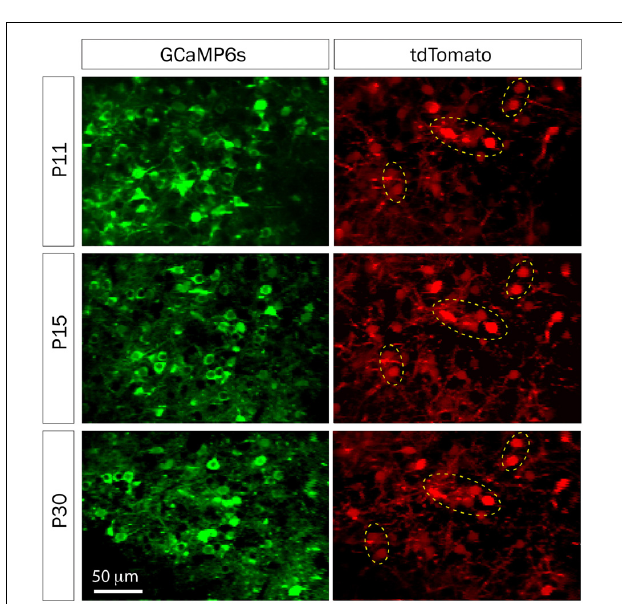
FIGURE 5 | td-Tomato expression to help identify the same GCaMP6s field of view for calcium imaging. Representative fields of view of GCaMP6s and td-Tomato-expressing neurons in barrel cortex of a mouse at three different postnatal ages. This animal was electroporated in utero at E16 with a plasmid encoding the red fluorescent protein td-Tomato and then was injected with rAAV-GCaMP6s at P1. Expression of td-Tomato allowed us to identify the same field of view throughout postnatal development because of stable expression of clusters of neurons in the red channel (yellow dotted ellipses).